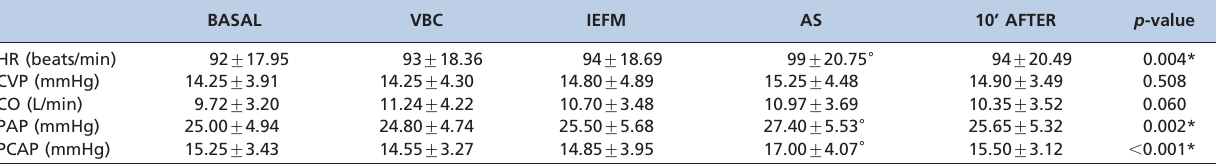
Table 2 - The results of the cardiovascular hemodynamic variables, reported as means and standard deviations. BASAL VBC IEFM AS 10’ AFTER p